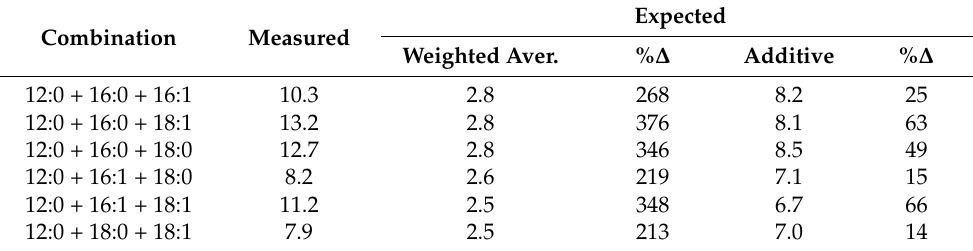
Table 1. Measured modulation of the PPAR reporter as fold-change vs. control—i.e., not FA treatment—in response to mixtures of three FA containing C12:0, compared to expected activa- tion based on the weighted average and additive model. % ∆ : percentage increase in measured PPAR modulation over expected